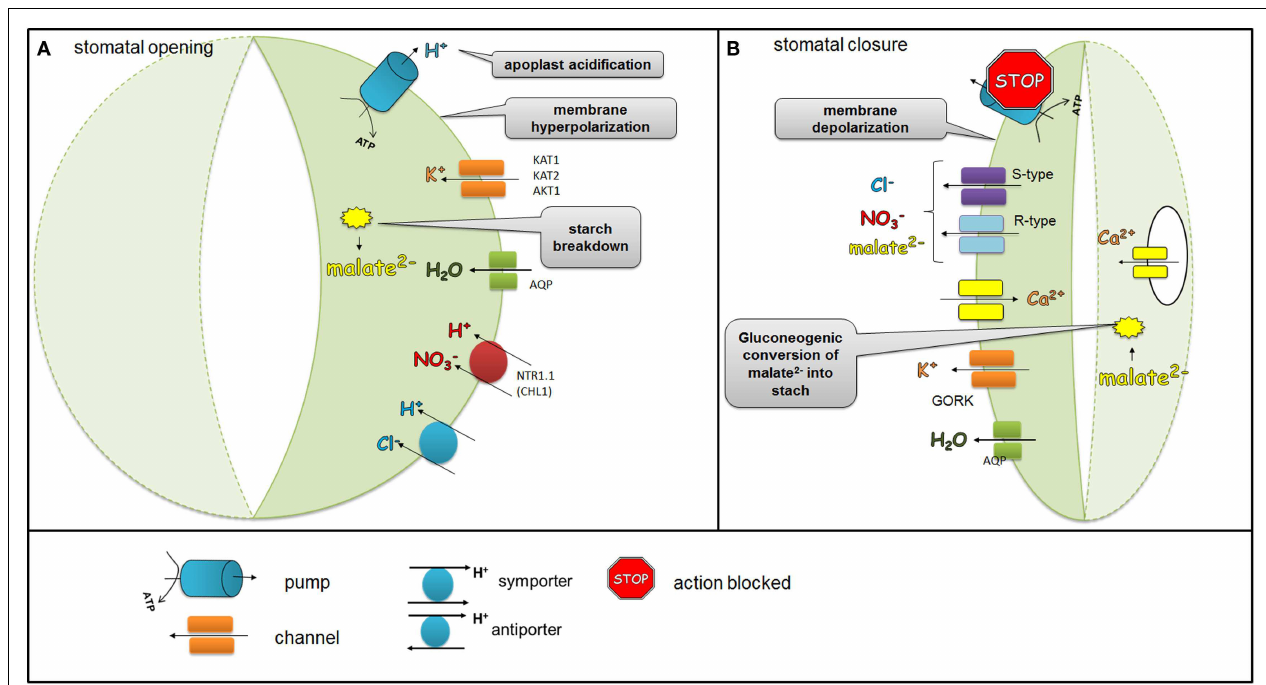
During stomatal closure (B) , H + -ATPase is inhibited and S-type and R-type anion channels are activated. As the plasma membrane is depolarized, S-type and R-type channels facilitate the efflux of malate 2 − , Cl − , and NO − At the same time, K + outwardly rectifying channels such as GORK are activated through the depolarization of the membrane, which leads to the efflux of K + .The decreased level of malate 2 − is also caused by the gluconeogenic conversion of malate into starch.The elevation of the Ca 2 + concentration as a result of the release of Ca 2 + - via channels situated in both the plasma membrane and in the tonoplast is another event that accompanies stomatal